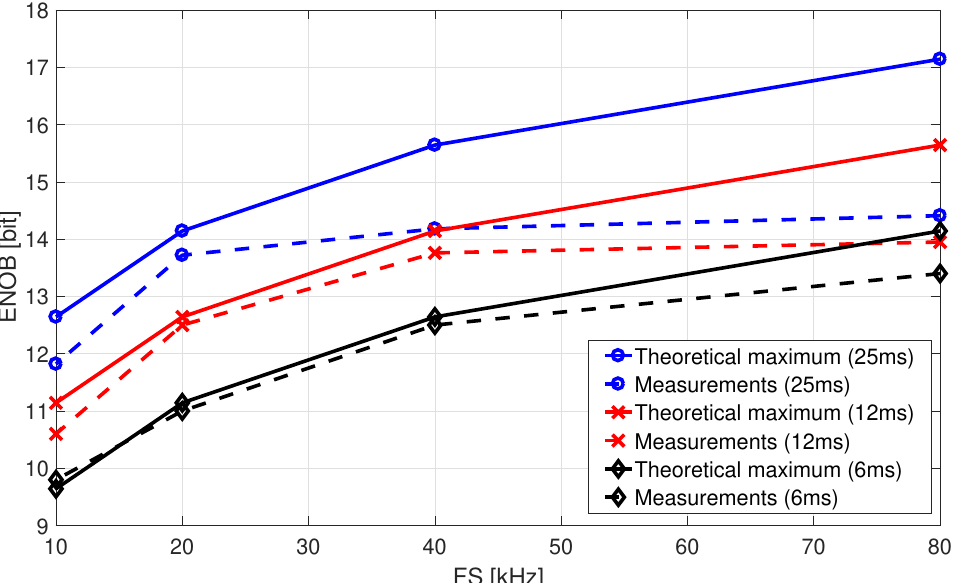
Figure 15. Performance scaling potential of measured CDC using 1024 consecutive measurements applying a on-chip capacitor dummy bridge at ≈ − 2